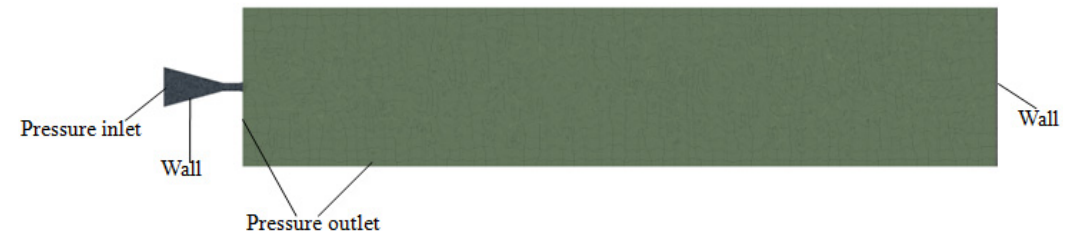
Figure 2. Computational Model.